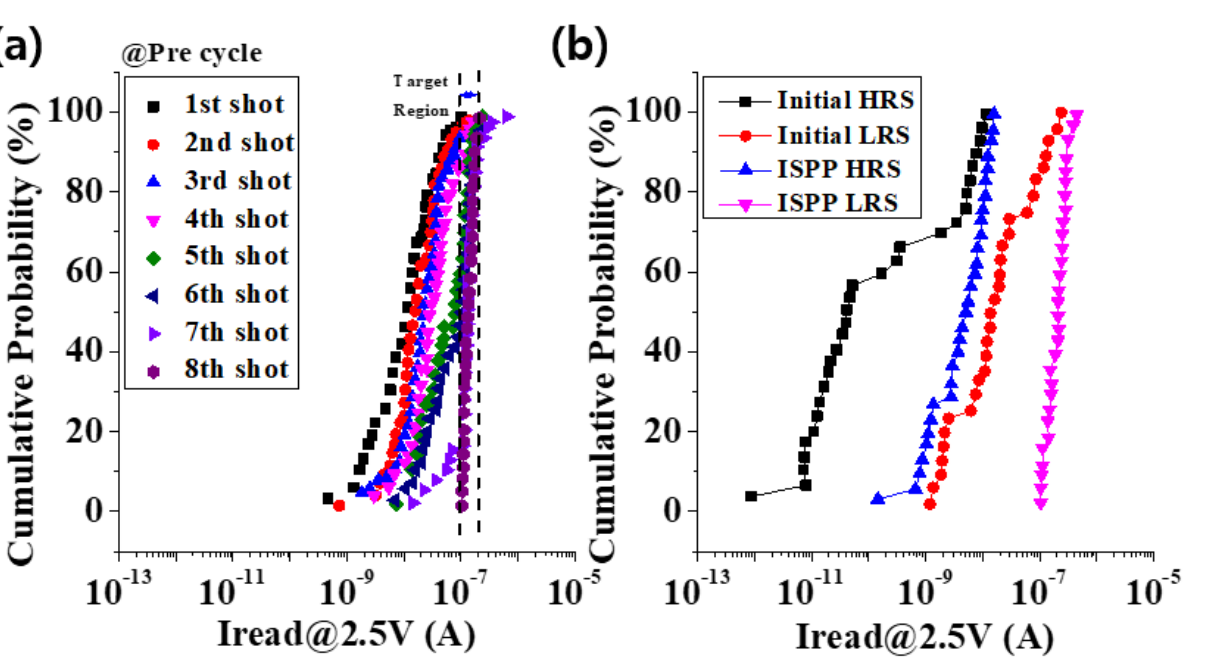
Figure 4. ( a ) Shows that the initial resistance states moved to the desired target range by the pre- cycle. ( b ) Comparison before and after applying ISPP algorithm. ( b ) Comparison before and after applying ISPP